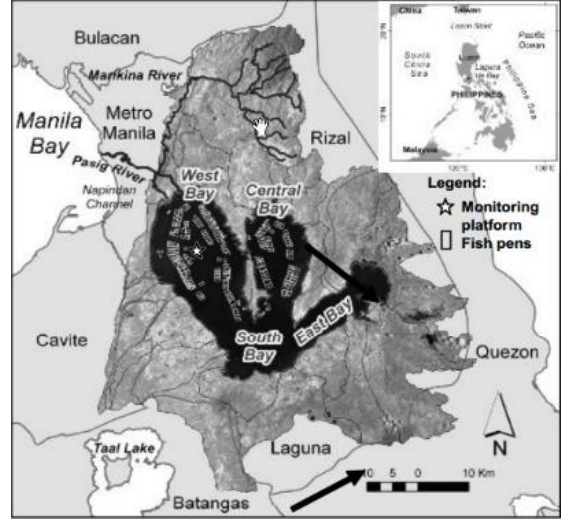
Figure 1. Laguna Lake and surrounding watershed which spans across Metro Manila and four provinces.